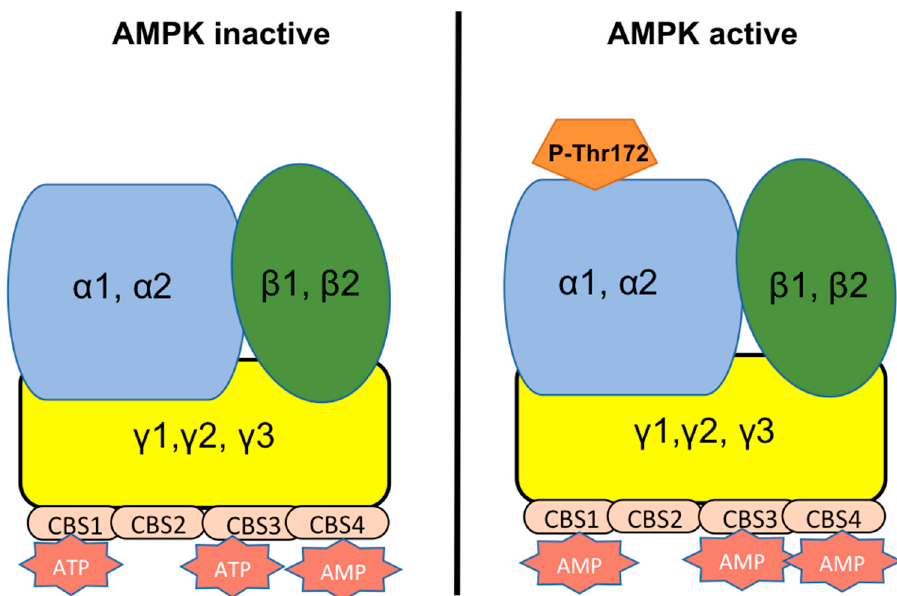
Figure 1. Structure of AMP-activated kinase (AMPK). AMPK is a heterotrimeric protein with 3 differents subunits: catalytic α (blue), scaffolding β (green) and regulatory γ (yelow), each one can be expressed as different isoforms, enabling distinct heterotrimeric combinations of AMPK. Regulatory subunit γ controls the activity of the α subunit through 4 tandem repeats of the motif CBS (cystathionine β -synthase) that bind adenosine nucleotides (AMP, ADP, ATP) with high affinity. AMPK remains inactive in presence of high levels of ATP, whereas during starvation or when ATP level decreases, CBS domains bind AMP, which favors the phosphorylation at Thr172 (catalytic α subunit) and subsequently leading to AMPK activation.